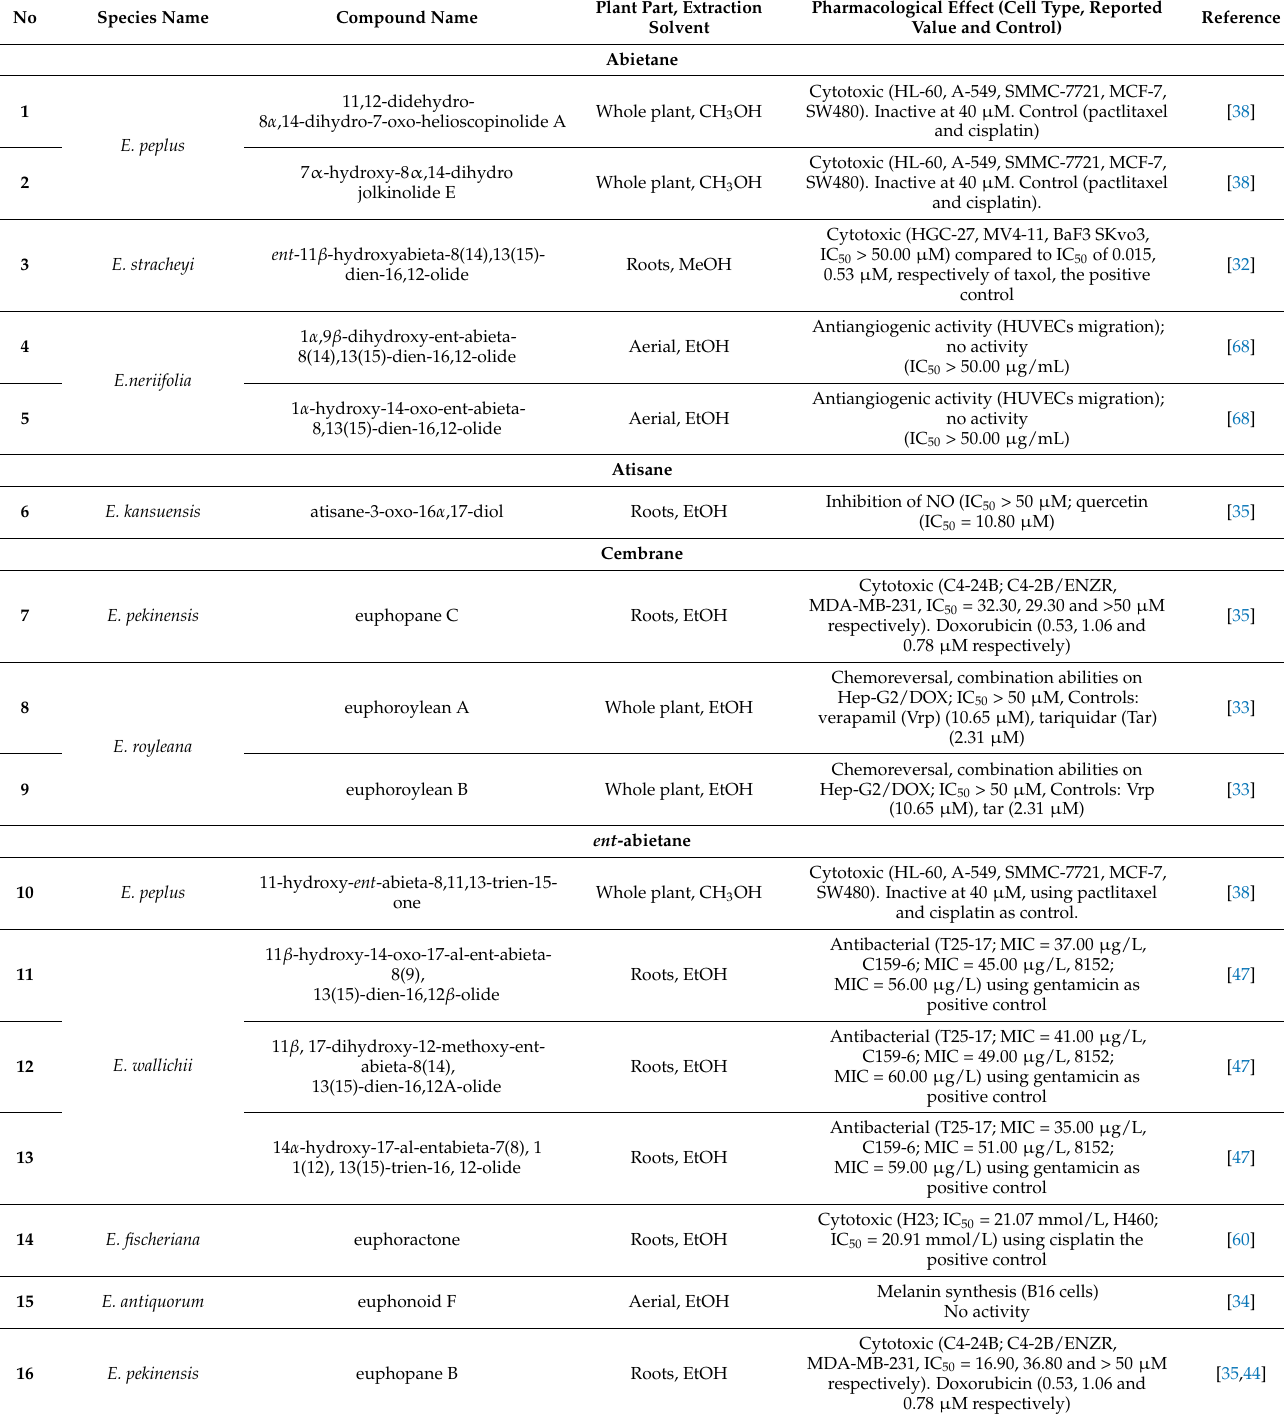
Table 2. Diterpenoids derived from Euphorbia species and their reported biological